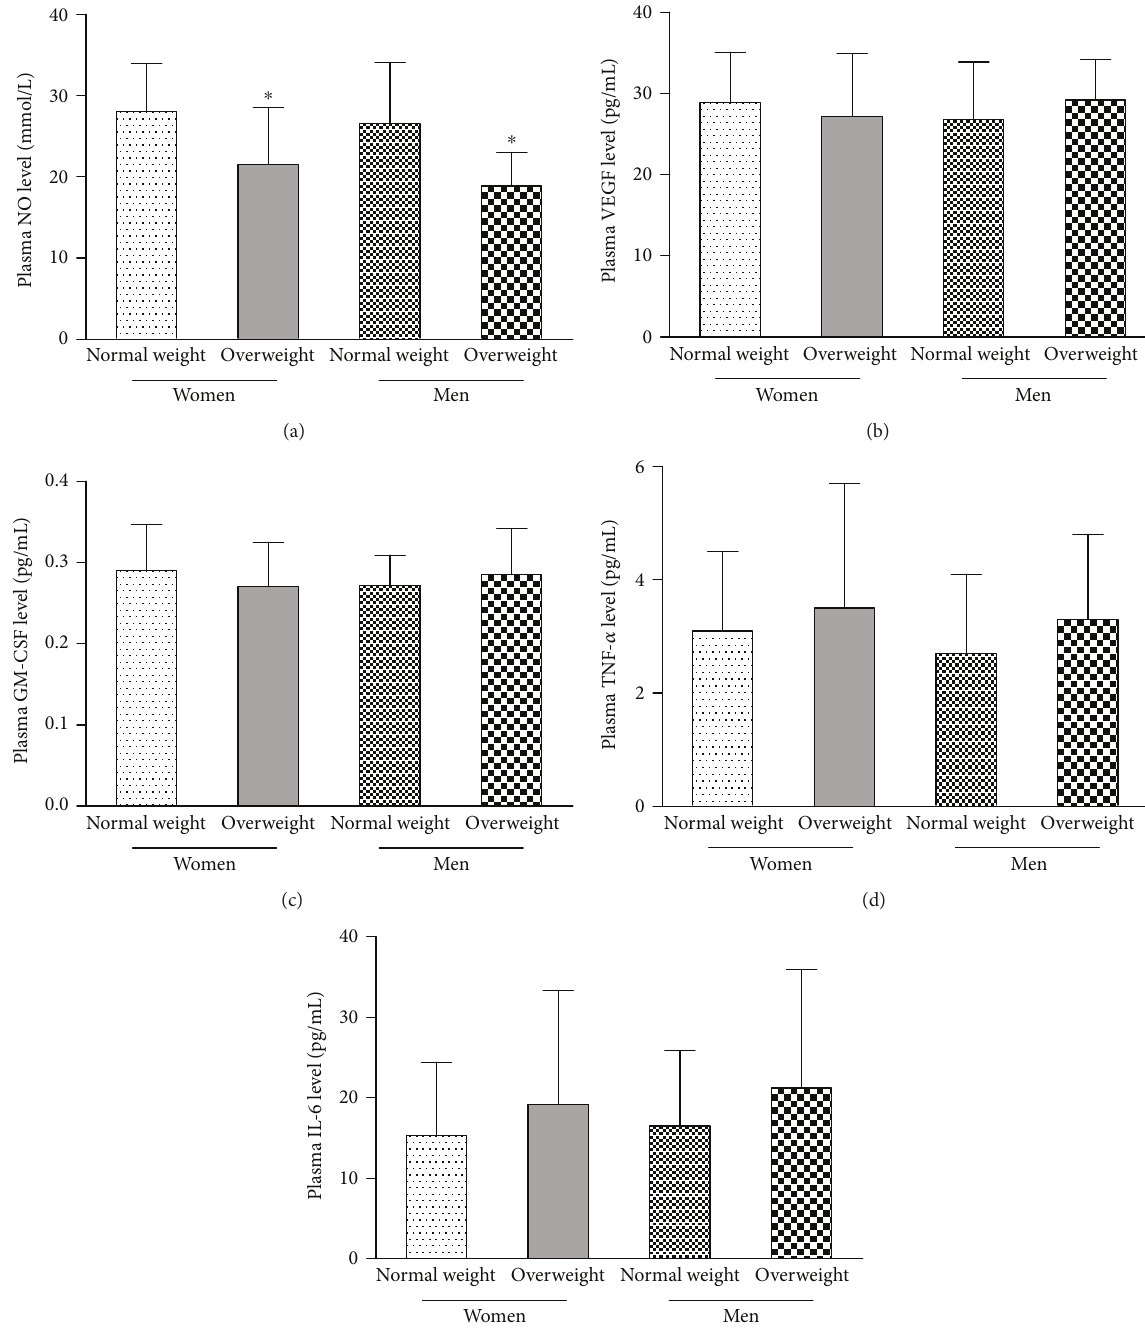
Figure 3: Plasma NO, VEGF, GM-CSF, TNF- α , and IL-6 levels were evaluated as follows. (a) The plasma NO level in normal weight and overweight men was similar to that in normal weight and overweight postmenopausal women. The plasma NO level was lower in overweight men and postmenopausal women than in normal weight men and postmenopausal women. There were no signi fi cant di ff erences in the plasma (b) VEGF or (c) GM-CSF levels among the four groups. There were no signi fi cant di ff erences in the plasma (d) TNF- α or (e) IL-6 levels among the four groups. Data are given as the mean ± SD. ∗ p < 0 05 versus normal